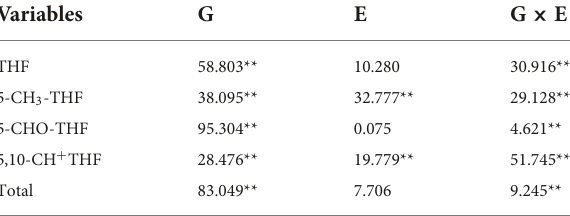
TABLE 2 Effect of genotype, environment, and their interaction on folate